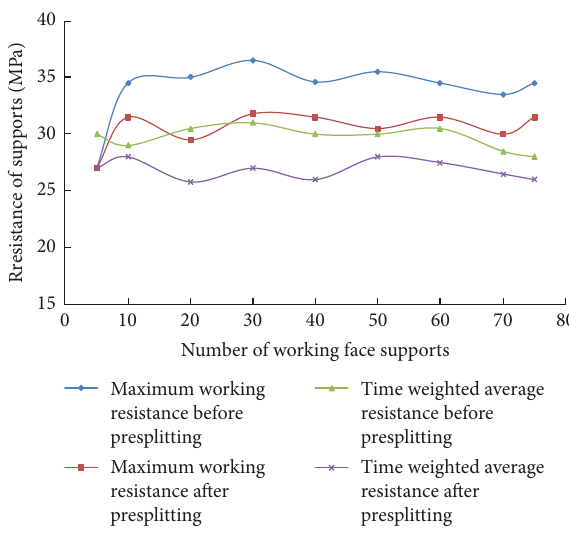
Figure 23: Comparison on working resistance of support before and after